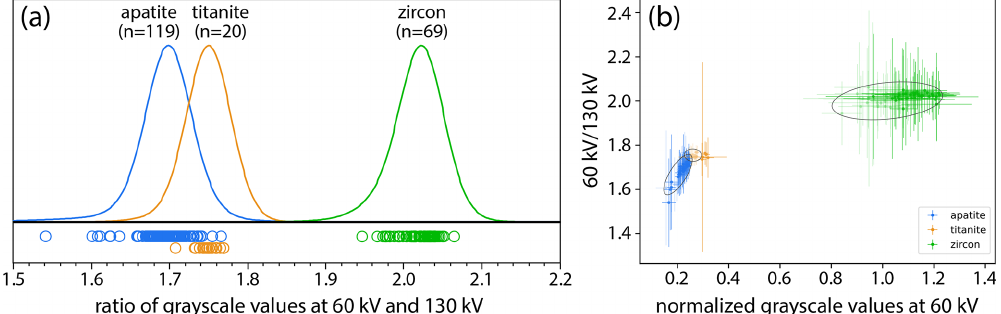
Figure 6. (a) Kernel density estimates of the ratios of the grayscale values at 60 and 130kV for grains from all three mounts. The mounts were scanned at 60 and 130kV with otherwise identical scan parameters and the grayscale values were measured at the same positions. Zircon and apatite form very distinct distributions, and the populations of apatite and titanite overlap but show more separation than grayscale values from scans at a single energy. (b) Dual-energy parameters plotted against normalized grayscale values at 60kV. Known standards are shown in lighter colors and black lines outline the field of values of standards. Unknown sample grains of apatites and zircons fall almost entirely within the field of standards. Titanite sample grains have a significantly different brightness (grayscale values) than sample grains but have the same dual-energy